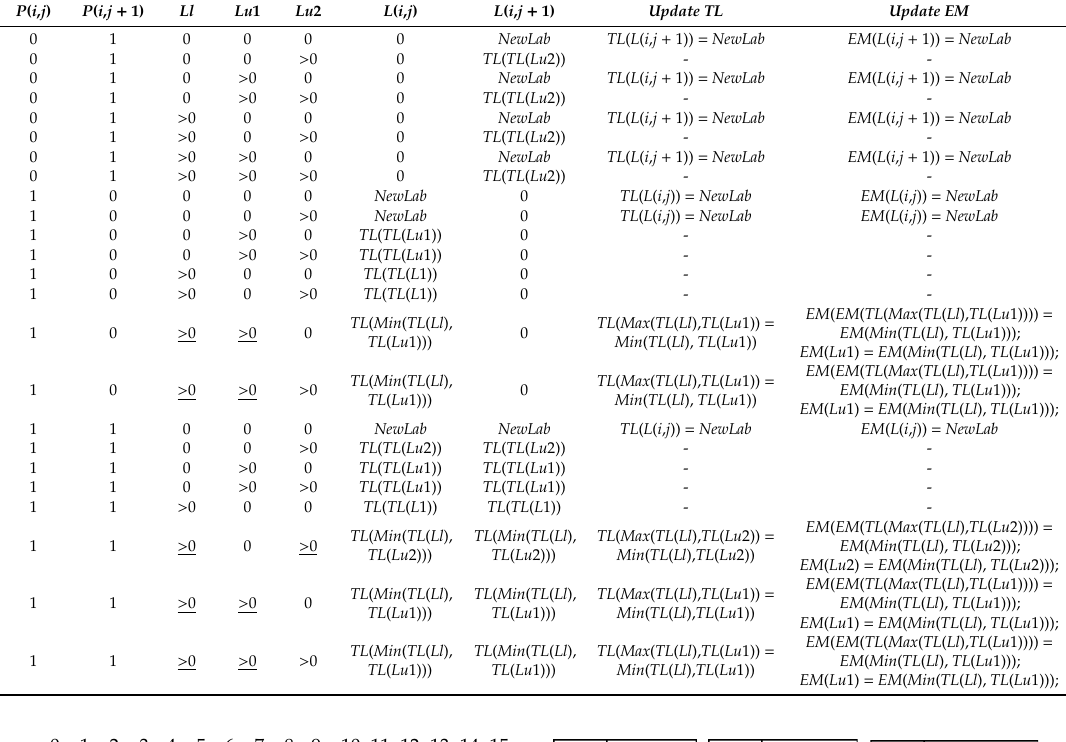
Figure 6. The neighborhoods of two adjacent input pixels: ( a ) four-connected; ( b ) eight-connected. Table 1. Rules to apply to four-connected neighborhoods for labeling two adjacent pixels in parallel.